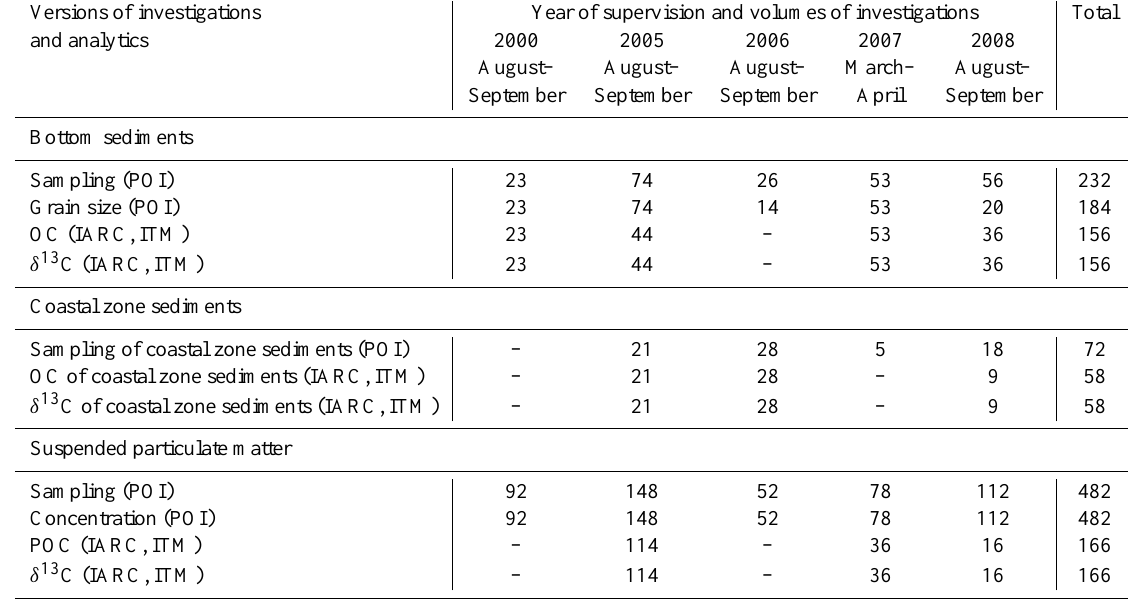
Table 2. Amounts of executed works and analytical researches of suspended particulate matter, bottom and coastal sediments samples.